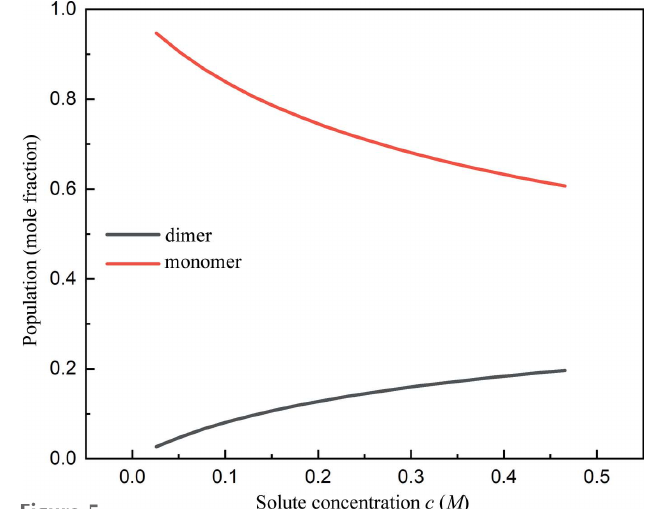
Figure 5 Population of monomers and dimers as a function of total solute